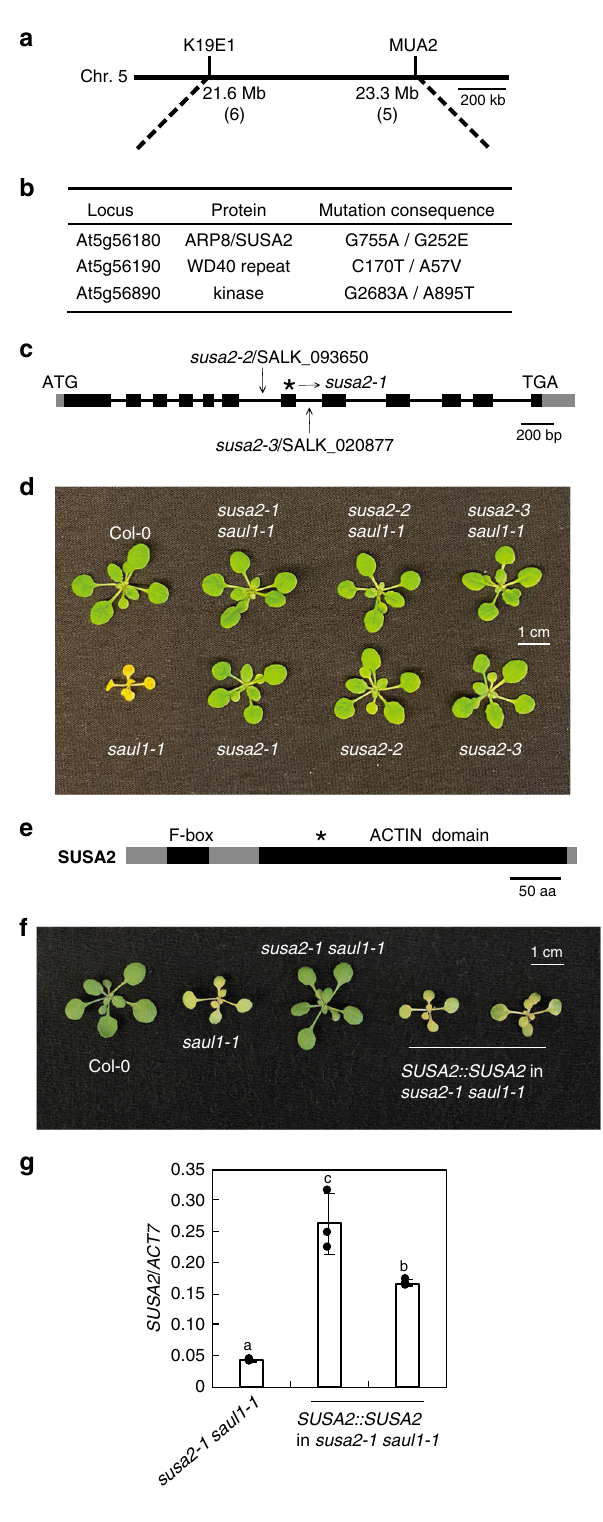
revealing different roles of the chaperone in NLR activation and stability control. Serine 100 is located in the ATP-binding pocket of HSP90.3, a highly conserved region among HSP90s from yeast, human, Caenorhabditis elegans ( C. elegans ), and several plant species (Fig. 3b). To con fi rm that this mutation in susa3-1 is responsible for suppressing saul1-1 , we crossed the previously reported hsp90.3-1 mutant with saul1-1 37 . As shown in Fig. 3c, as with susa3-1 , hsp90.3-1 largely suppresses the autoimmune